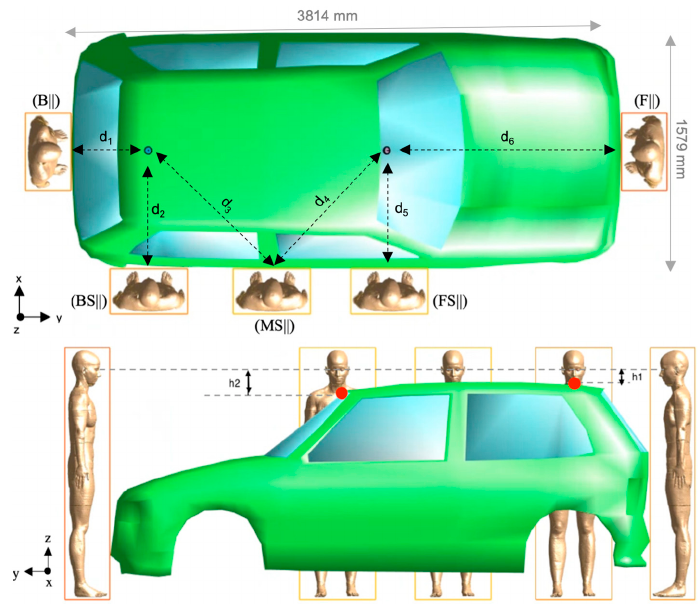
Figure 2. ( Top panel): Top view of the human model in the front (F||), back (B||), front-side (FS||), middle-side (MS||), and back-side (BS||) configuration. This picture also displays the dimensions of the car and the distances “d” between the Huygens’ Box and the antennas: d 1 = 536 mm, d 2 = d 5 = 815 mm, d 3 = d 4 = 1179 mm, d 6 = 1608 mm. ( Bottom panel): Lateral view of the car and the human model in the different configurations. The relative height between the eyes and the rear antenna is h 1 = 80 mm and that between the eyes and the front antenna is h 2 = 155 mm. The yellow rectangle is the “Huygens’ Box” used in the FDTD method to calculate the dose of the EMF absorbed by the human model (see the details in Section 2.2, “Electromagnetic field calculation”).